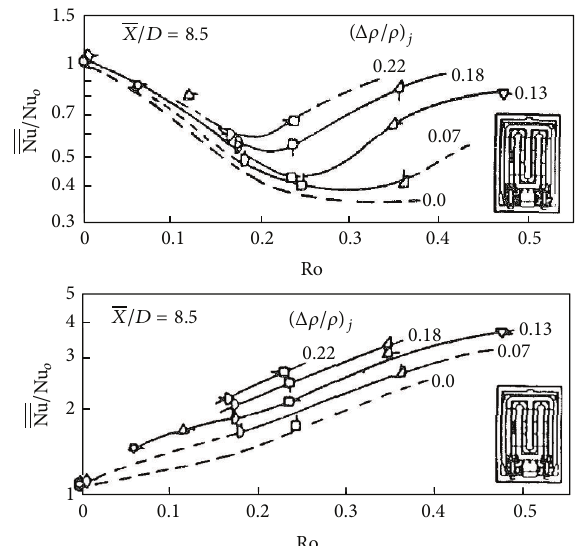
Figure 26: Spatially averaged Nusselt number ratio variations as dependent upon inlet density ratio and rotation number for the rotating channel investigation of Wagner et al. [103]. Results for a radial outflow arrangement are presented for suction (top figure) and pressure (bottom figure) sides of the rotating passage.